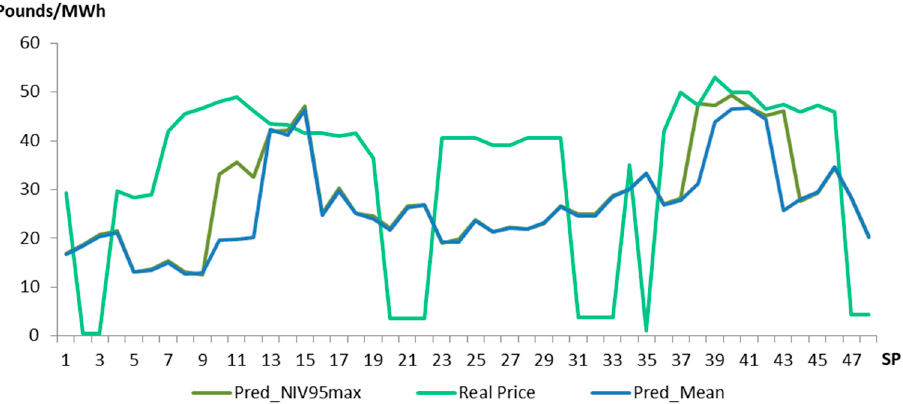
Figure 8. Model price prediction mean and NetImbVol 95% quantile vs. real data for 48 SP (test on 23